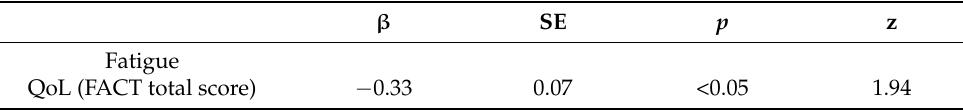
Table 3. Indirect effects on PTSD (N = 123).